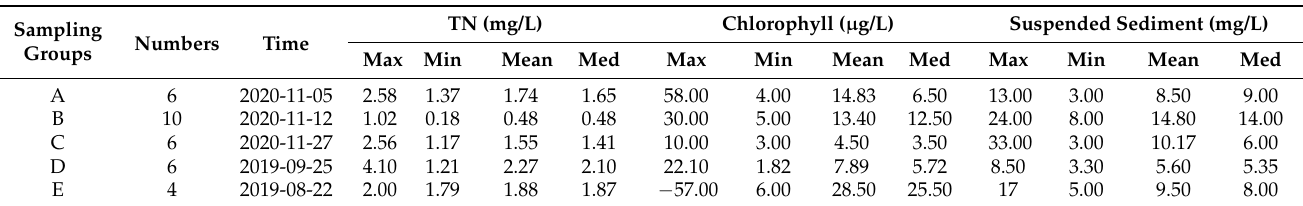
Table 1. Water quality analysis results of sampling sites. This table contains five sampling groups and their numbers. Each sampling group has statistical data of maximum, minimum, mean and median of material